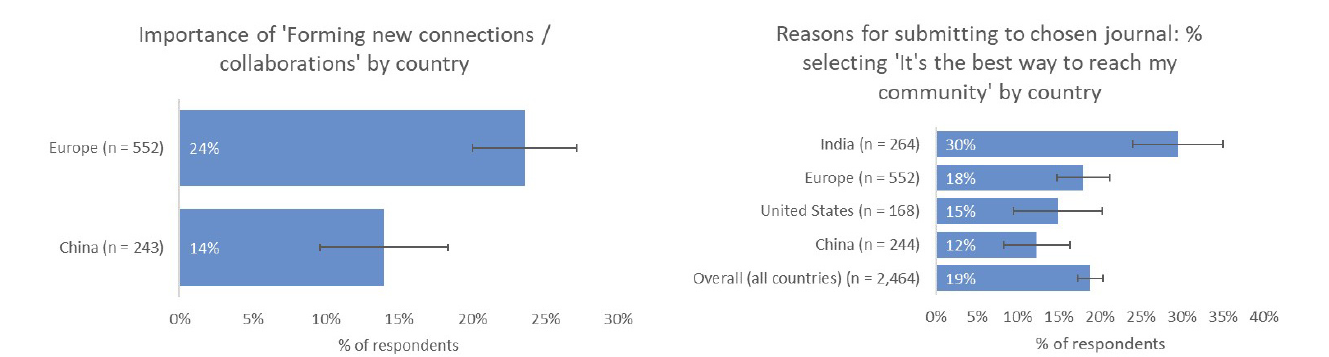
Figure 13. Relative importance of new collaborations as a form of impact for Europe- and China-based authors.